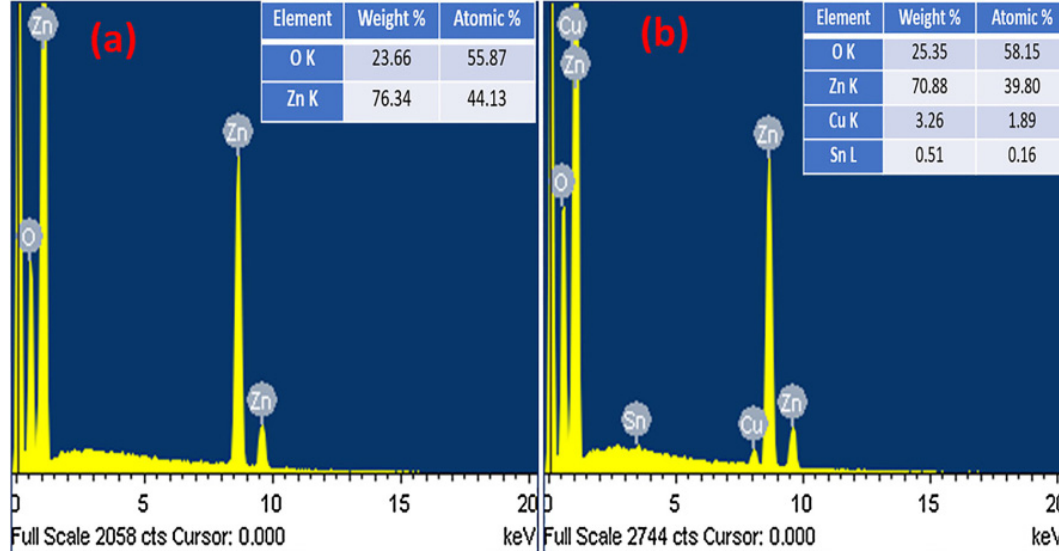
Figure 7. EDX spectra of ZnO ( a ) and Sn:Cu/ZnO ( b ) nanoparticles [121].